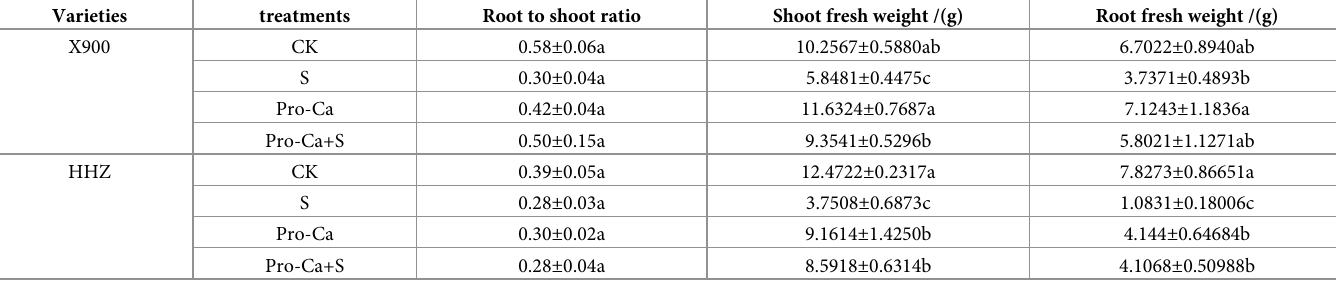
Values represent the mean ± SE ( n = 3), and different lowercase letters indicate significant differences according to Duncan’s